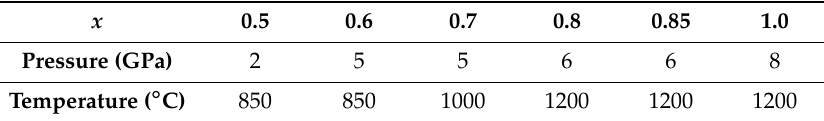
Table 2. Synthesis conditions of Li x WO 3 .